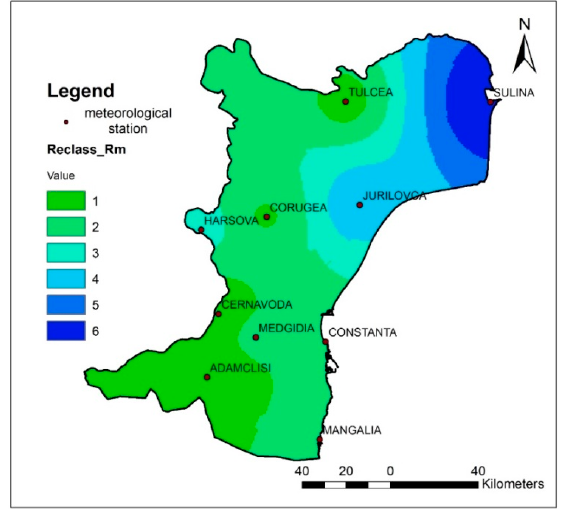
Figure 7. Multiannual precipitation data set reclassified. 325